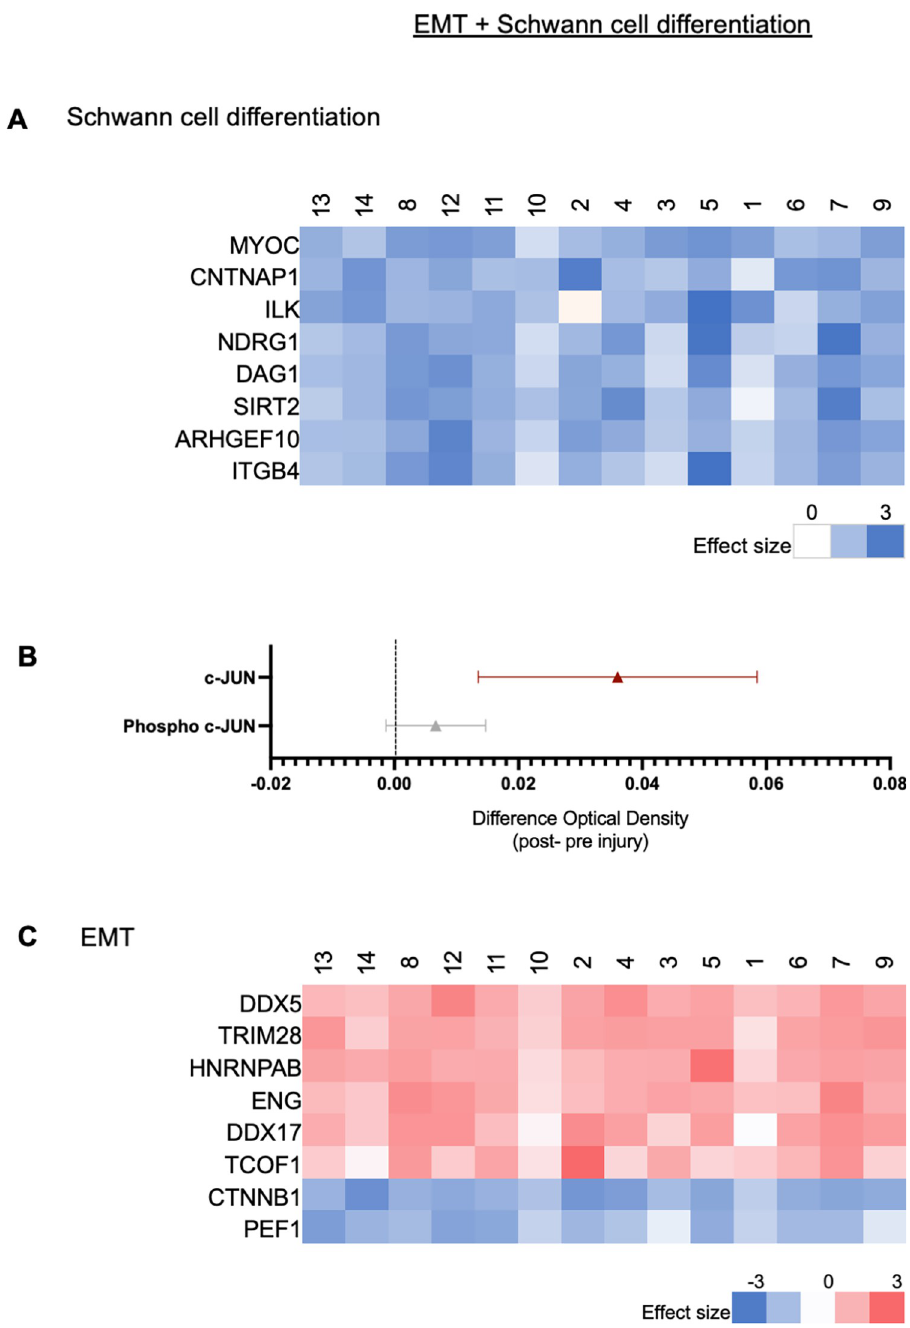
Fig 7. Changes in Schwann cell phenotype after injury based on the GO pathway “Schwann cell differentiation”. A . Mass spectrometry: All the proteins that were significantly upregulated or downregulated (q-value � 0.05 and Z � | 2|, range -3 to 3). B. Immunoassay: The mean difference of c-JUN and its activated form phospho c-JUN content, in the na ï ve and injured tissue and 95% CI bands. Red markers represent mean difference CI that was above zero and gray one represent mean difference CI that included zero. C. Graph of mass spectrometry analysis of all the protein products that were significantly upregulated or downregulated from the GO pathway, “EMT”.